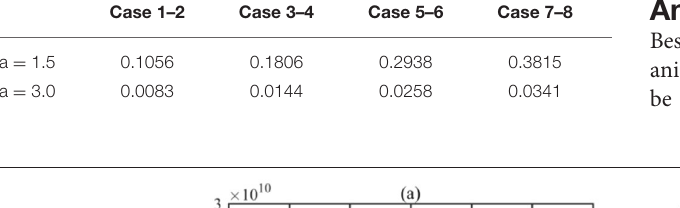
Frontiers in Earth Science |